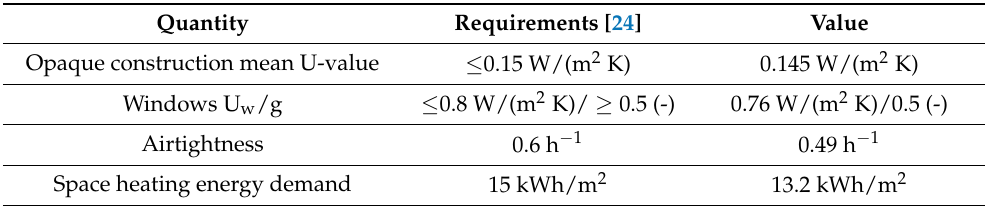
Table 1. Summary table of building passive house